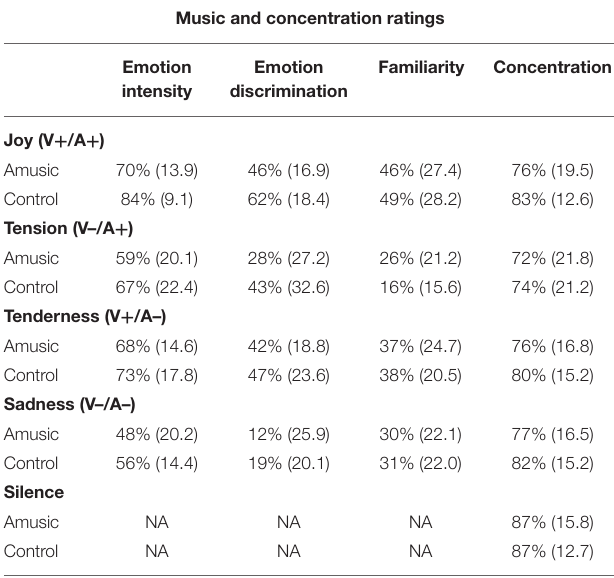
TABLE 4 | Music and Concentration ratings for both amusic and control participants